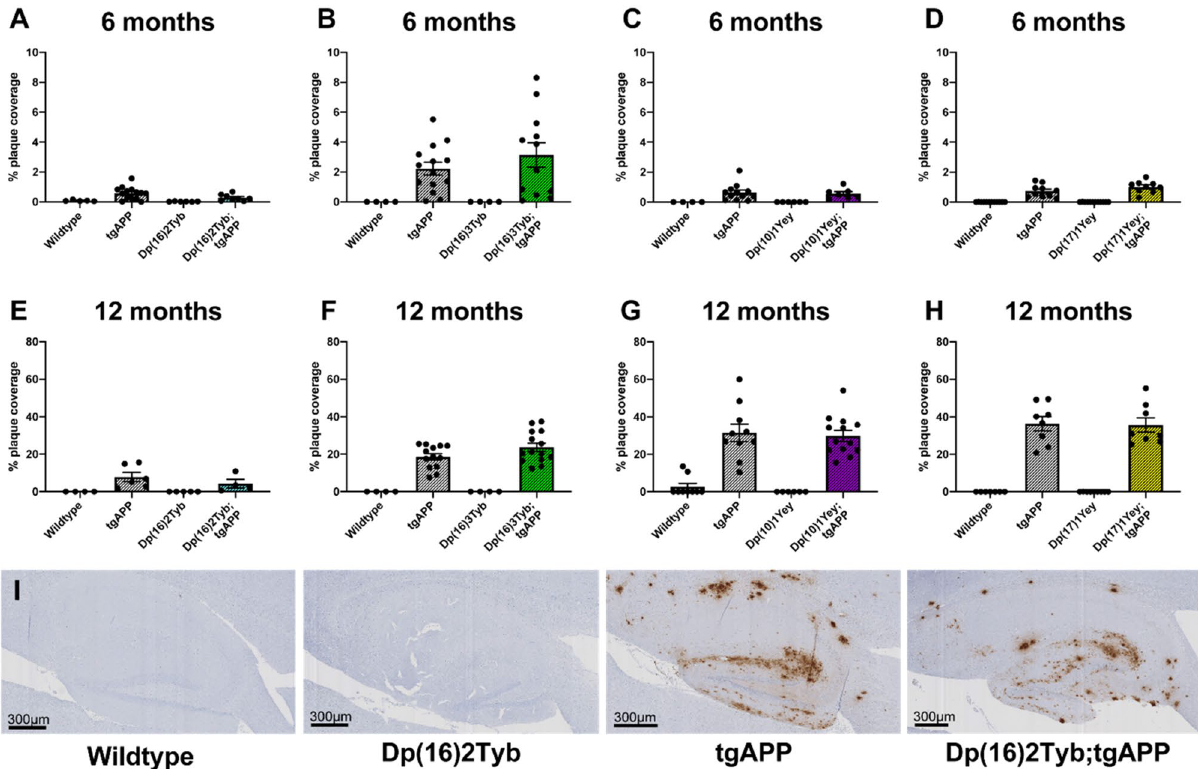
Figure 5. The effect of DS segmental duplication models on amyloid-β in the hippocampus. Amyloid-β deposition in the hippocampus was quantified at ( A – D ) 6- and ( E – H ) 12-months of age in male and female mice, percentage of the region covered by stain was calculated. Error bars show SEM, data points are independent mice. ( A ) No significant difference in amyloid-β deposition in the hippocampus was detected at 6-months of age in Dp(16)2Tyb;tgAPP compared with tgAPP controls (F(1,17) = 2.372, p = 0.142) detected with 82E1 primary antibody. After systematic outlier testing one tgAPP sample was excluded prior to analysis. Dp(16)2Tyb;tgAPP female n = 5, male n = 3; tgAPP female n = 7, male n = 7. ( B ) No significant difference in amyloid-β deposition in the hippocampus was detected at 6-months of age in Dp(16)3Tyb;tgAPP compared with tgAPP controls ( U (N Dp(16)3Tyb;tgAPP = 12, N tgAPP = 14,) = 71, p = 0.5267) detected with 82E1 primary antibody. Dp(16)3Tyb;tgAPP female n = 6, male n = 6; tgAPP female n = 7, male n = 7. ( C ) No significant difference in amyloid-β deposition in the hippocampus was detected at 6-months of age in Dp(10)1Yey;tgAPP compared with tgAPP controls (F(1,14) = 0.001, p = 0.972) detected with 4G8 primary antibody. Dp(10)1Yey;tgAPP female n = 4, male n = 3; tgAPP female n = 5, male n = 7. ( D ) No significant difference in amyloid-β deposition in the hippocampus was detected at 6-months of age in Dp(17)1Yey;tgAPP compared with tgAPP controls (F(1,14) = 1.785, p = 0.203) detected with 4G8 primary antibody. Dp(17)1Yey;tgAPP female n = 5, male n = 4; tgAPP female n = 6, male n = 4. ( E ) No significant difference in amyloid-β deposition in the hippocampus was detected at 12-months of age in Dp(16)2Tyb;tgAPP compared with tgAPP controls (F(1,5) = 1.908, p = 0.226) detected with 82E1 primary antibody. Dp(16)2Tyb;tgAPP female n = 3, male n = 1; tgAPP female n = 3, male n = 3. ( F ) No significant difference in amyloid-β deposition in the hippocampus was detected at 12-months of age in Dp(16)3Tyb;tgAPP compared with tgAPP controls (F(1,22) = 2.012, p = 0.170) detected with 82E1 primary antibody. Dp(16)3Tyb;tgAPP female n = 8, male n = 6; tgAPP female n = 7, male n = 7. ( G ) No significant difference in amyloid-β deposition in the hippocampus was detected at 12-months of age in Dp(10)1Yey;tgAPP compared with tgAPP controls (F(1,18) = 0.131, p = 0.722) detected with 4G8 primary antibody. Dp(10)1Yey;tgAPP female n = 7, male n = 6; tgAPP female n = 6, male n = 4. ( H ) No significant difference in amyloid-β deposition in the hippocampus was detected at 12-months of age in Dp(17)1Yey;tgAPP compared with tgAPP controls (F(1,11) = 0.021, p = 0.886) detected with 4G8 primary antibody. Dp(17)1Yey;tgAPP female n = 5, male n = 3; tgAPP female n = 5, male n = 3. ( I ) Representative image of Dp(16)2Tyb;tgAPP hippocampus at 12-months of